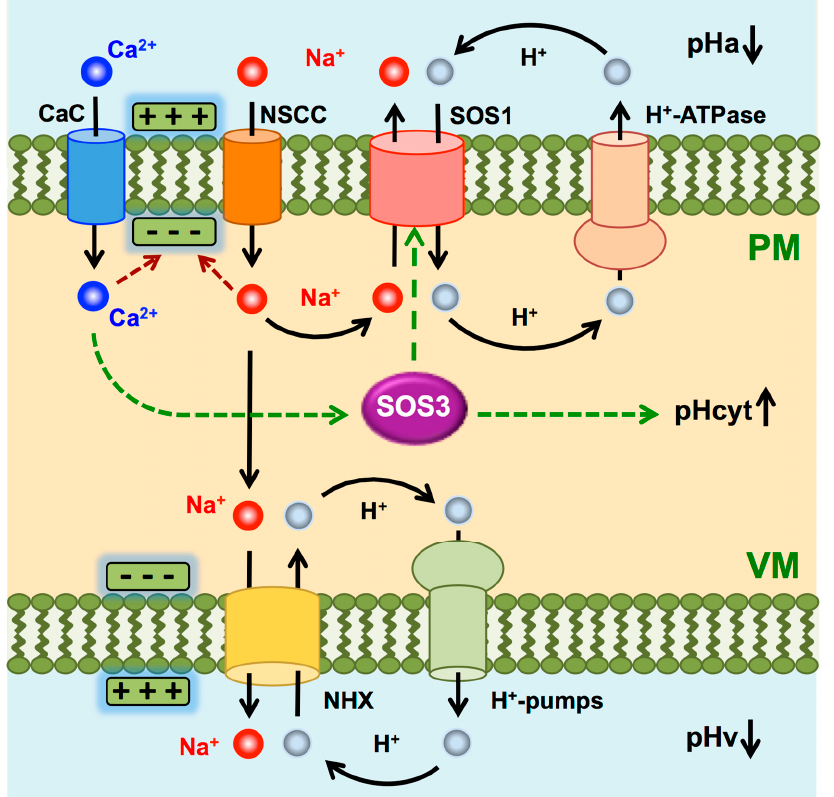
Figure 11. Model of ion transport processes relevant to salinity-induced shifts in pHcyt. For simplicity, only the salt-induced Ca 2+ entry, Na + fluxes, and H + cycles are shown. K + and Cl − fluxes are omitted. Under salinity stress, Na + and Ca 2+ entry elicit depolarization of the PM, which activates the H + - pump to repolarize the membrane. Intracellular Na + is extruded by SOS1 at the expense of the H + gradient created by the H + -pump. Similar fluxes take place at the tonoplast for Na + compartmentation in the vacuole. The enhanced proton-motive force created by pumps at both membranes should be of sufficient magnitude to energize Na + transport with the predicted result of cytoplasmic alkalinization. However, this salt-induced rise in pHcyt was not observed in the sos3-1 mutant, suggesting that the operation of the SOS pathway is necessary to create the alkalinization response. The Ca 2+ entry activates SOS3 that in turn promotes Na + /H + exchange by SOS1. Salt-induced alkalinization is not a symptom of disturbed ion homeostasis but the consequence of the activation of the SOS pathway. PM: plasma membrane; VM: vacuolar membrane; CaC: Ca 2+ channel; NSCC: non-selective cation channel; NHX: Na + ,K + /H + exchanger at the tonoplast; H + -pumps: V-ATPase and pyrophosphatase; pHa: apoplastic pH; pHcyt: cytosolic pH; pHv: vacuolar pH. Green boxes with +/ − symbols represent the electrical membrane potential; dashed green and red arrows mean positive and negative effects,